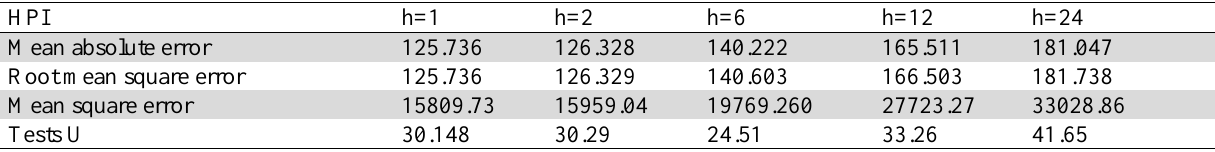
Forecasting of HPI index out of sample HPI h=1 Mean absolute error